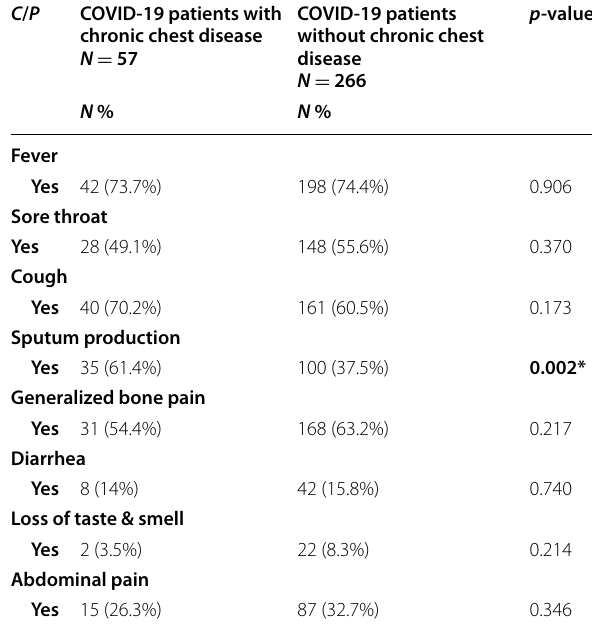
Table 2 Difference in clinical picture in COVID-19 patients with CRD and without